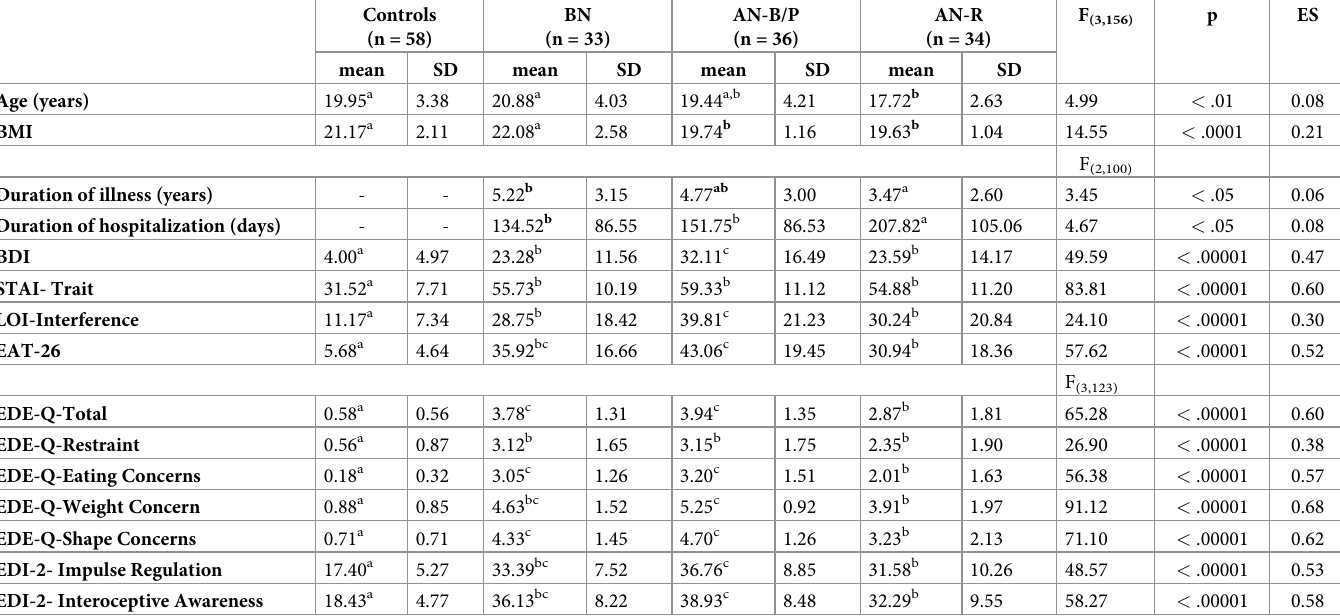
Table 5. Demographic, clinical and psychometric variables: Four-group analysis